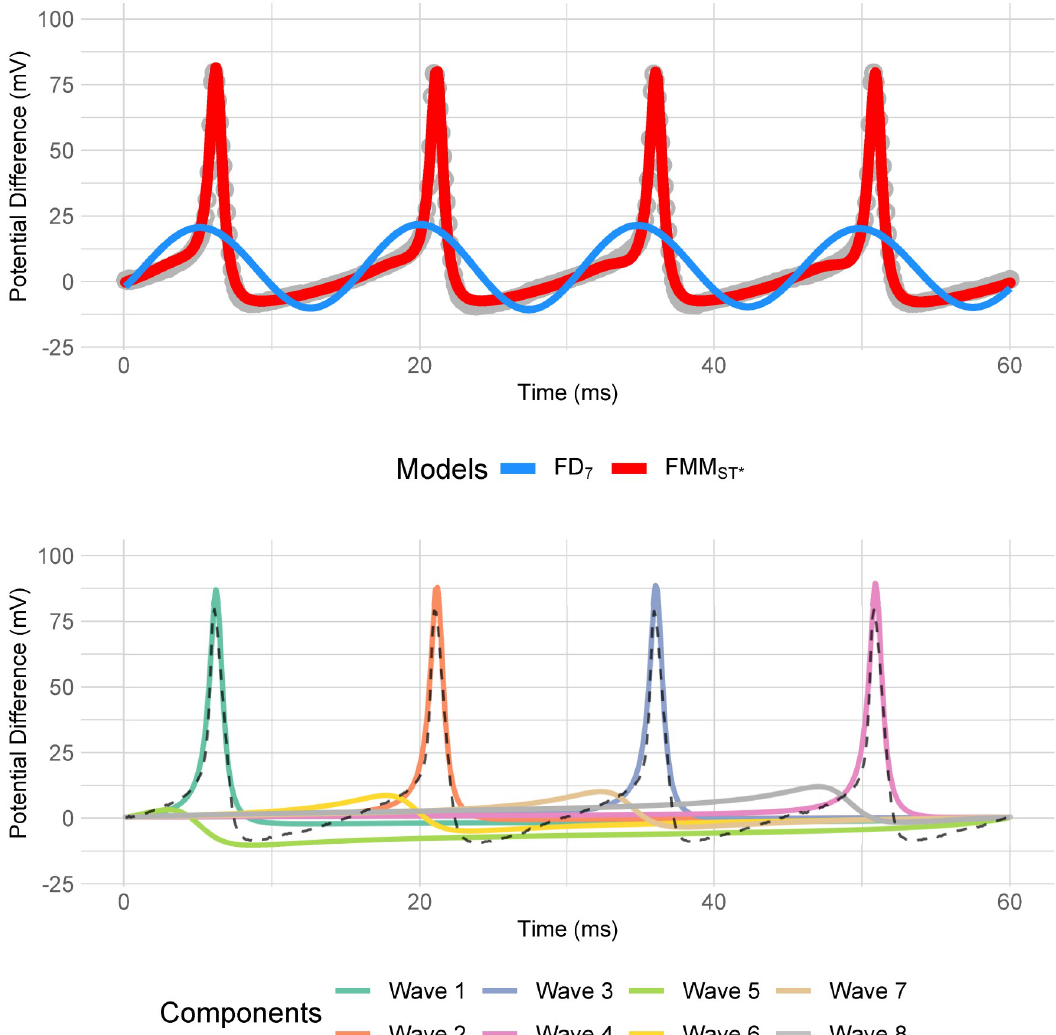
Fig 5. Neuronal APs from the SGAMP database (axon 1, trial 18, second short square stimulus) along with the fitted signals using an FMM ST � signal (red) and an FD 7 (blue). The waves of the fitted FMM ST � model are illustrated at the bottom.